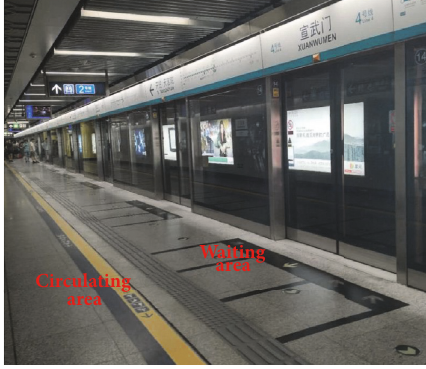
Figure 2: Waiting areas at the platform.